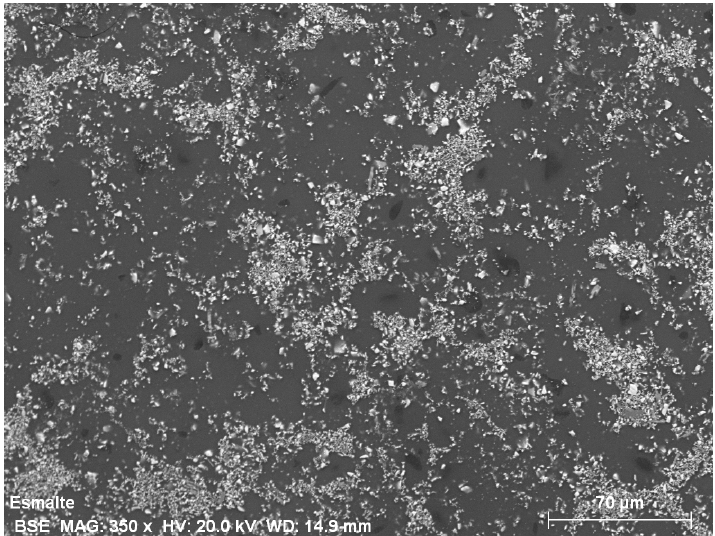
Figure 11. SEM applying 350 magnifications of the tile’s second layer of glaze or final glaze.